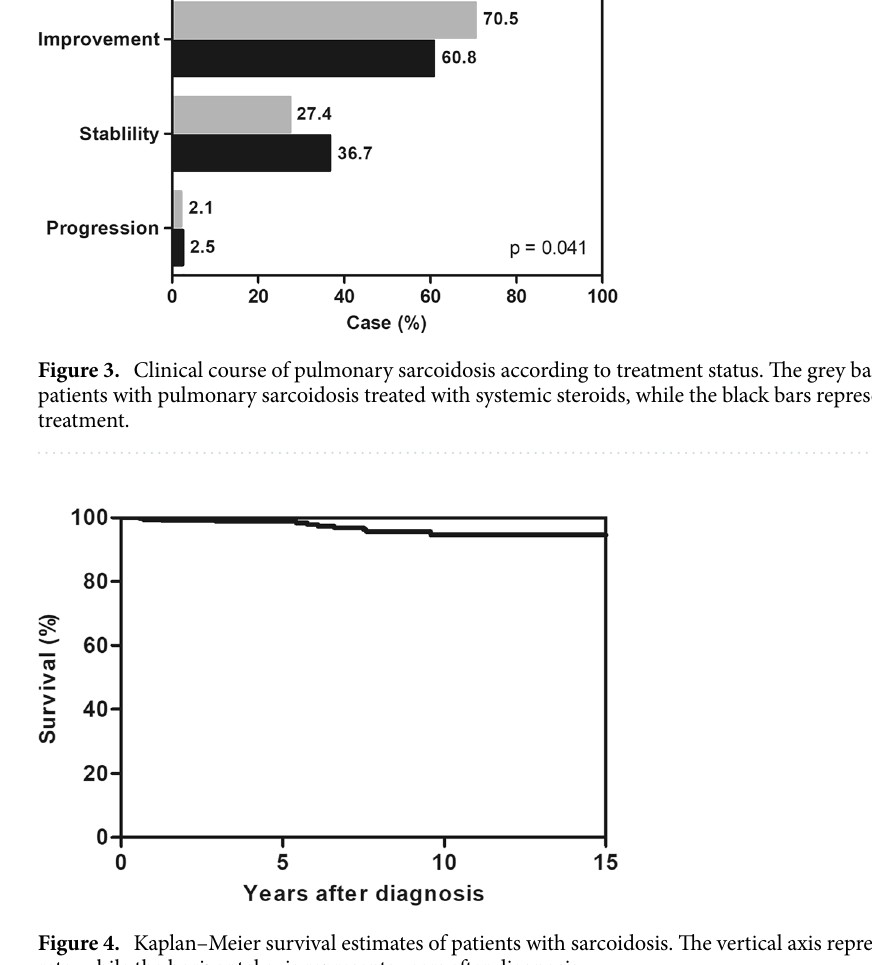
Figure 4. Kaplan–Meier survival estimates of patients with sarcoidosis. The vertical axis represents survival rate, while the horizontal axis represents years after